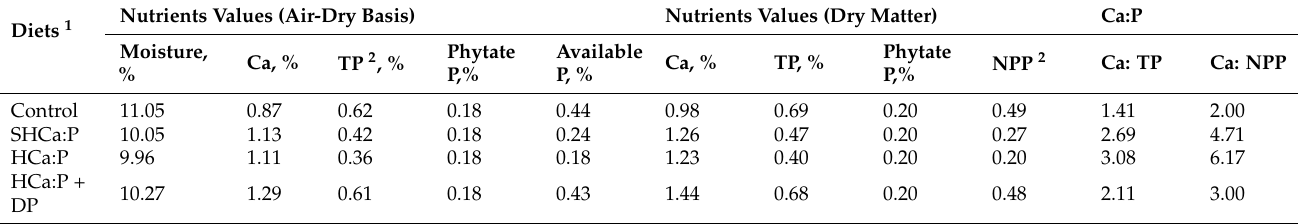
Table 2. Calcium (Ca) and phosphorus (P) levels for each treatment in trials one, two and three. Diets